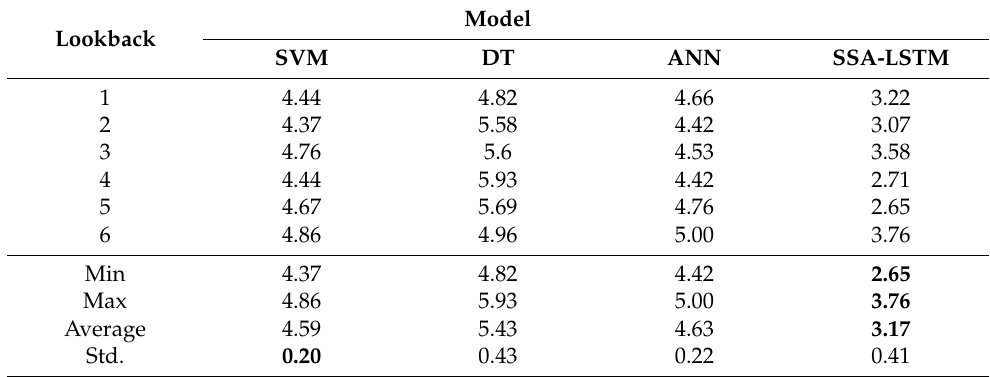
Table 3. Performance of the proposed model (SSA-LSTM) compared to three benchmark methods, namely SVM, DT, and